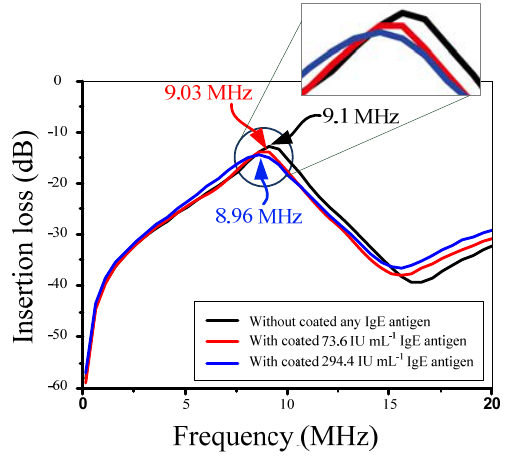
Figure 16. Frequency responses of the FPW allergy biosensor.